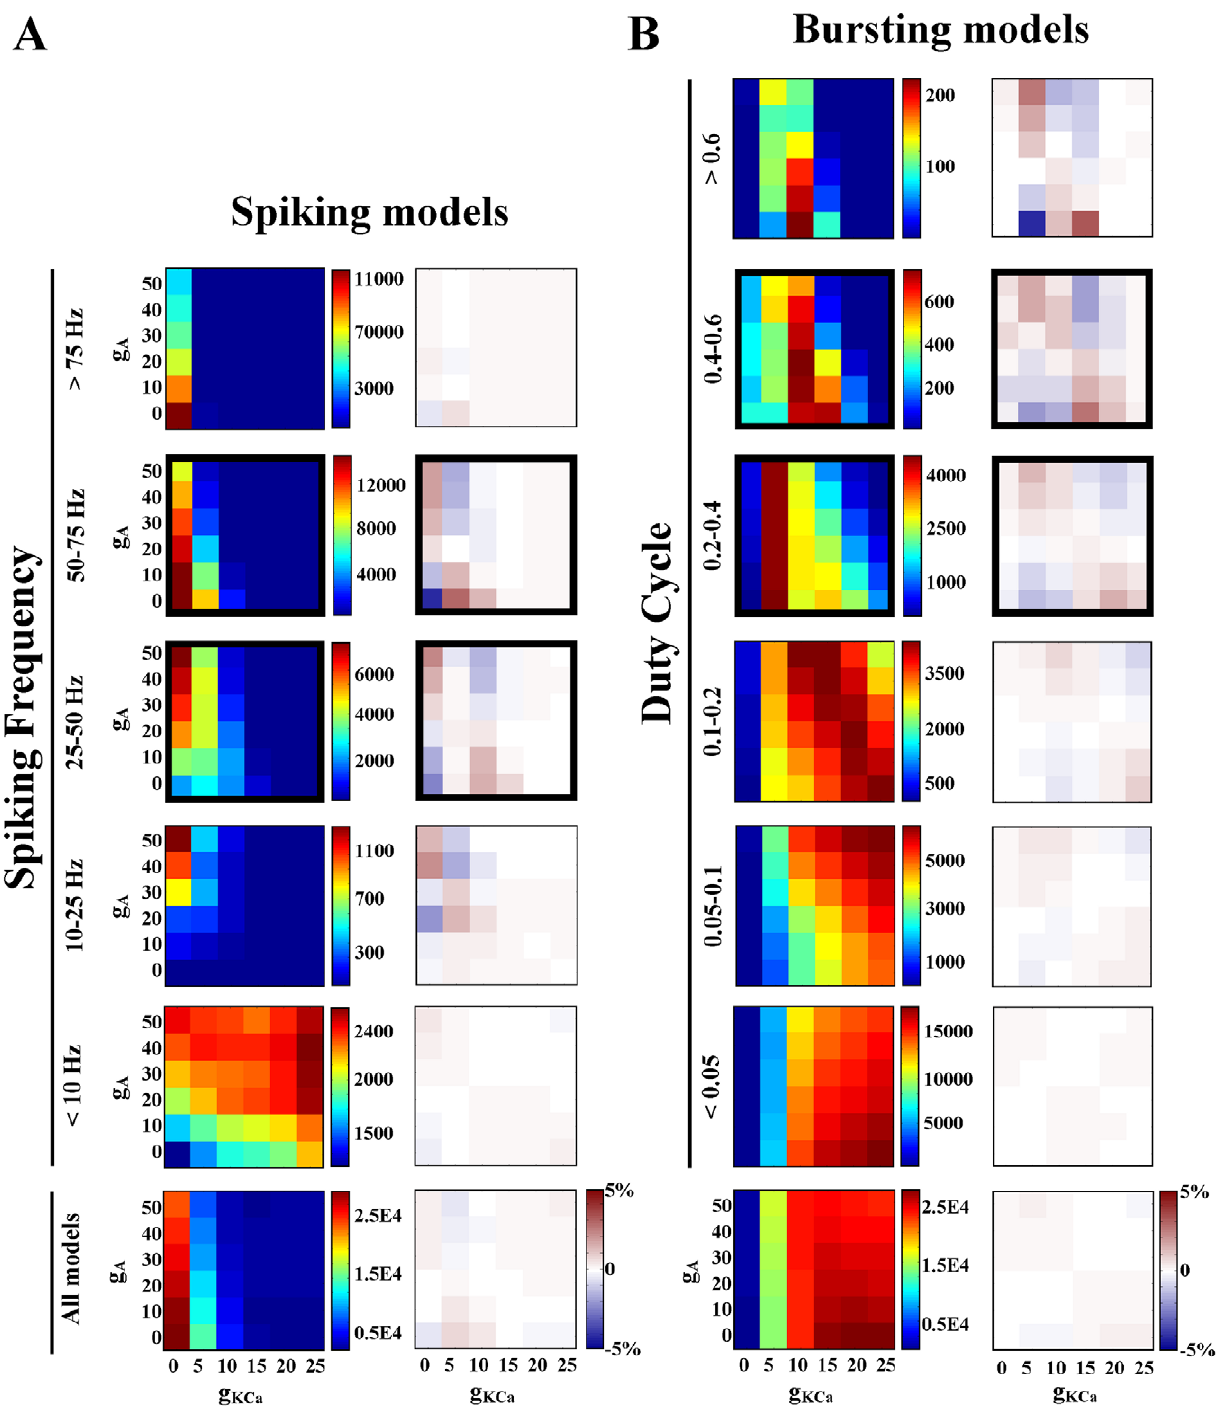
Figure 7. Values of g A and g KCa are correlated for spiking models with a frequency between 25 and 75 Hz and bursting models with duty cycle between 0.2 and 0.6. Spiking models are represented by the leftmost two columns (A), and bursting models are shown to the right (B). Frequency or duty cycle range is specified to the left of each pair of plots, excluding the bottom row which represents all spiking or bursting models. Bold black borders indicate a correlation ( x 2 . 500 and | r | . 0.2). The g A and g KCa relationship in bursting models with duty cycle . 0.6 (top right) was considered a false negative result ( x 2 =262, r = 2 0.33). differences in slope for the same correlation in different activity single conductance pair was different in each cell type [9]. In types (Figure 7). This is reminiscent of the cell-type specific addition, we saw correlations which maintained slope but differed correlations found by Schulz et al.; the correlation slope for a between activity types with regard to intercept (Figure 8). We can